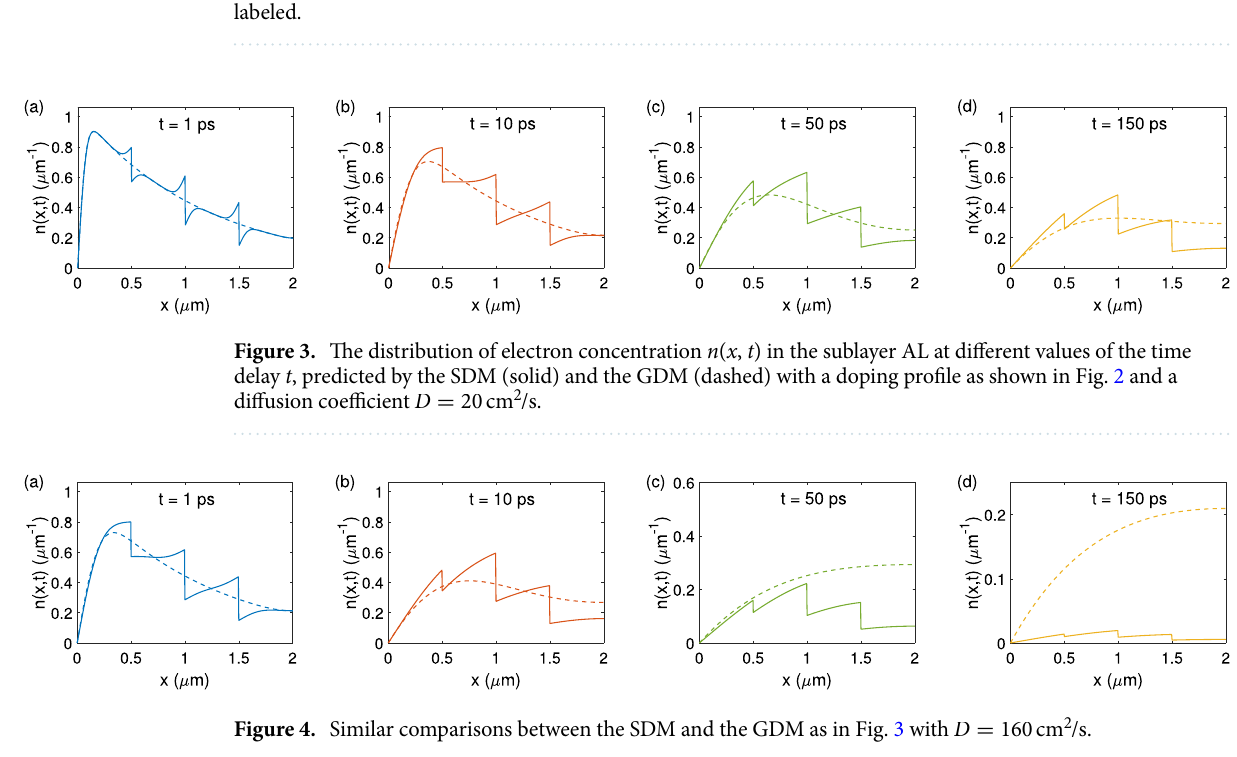
Figure 4. Similar comparisons between the SDM and the GDM as in Fig. 3 with D = 160 cm